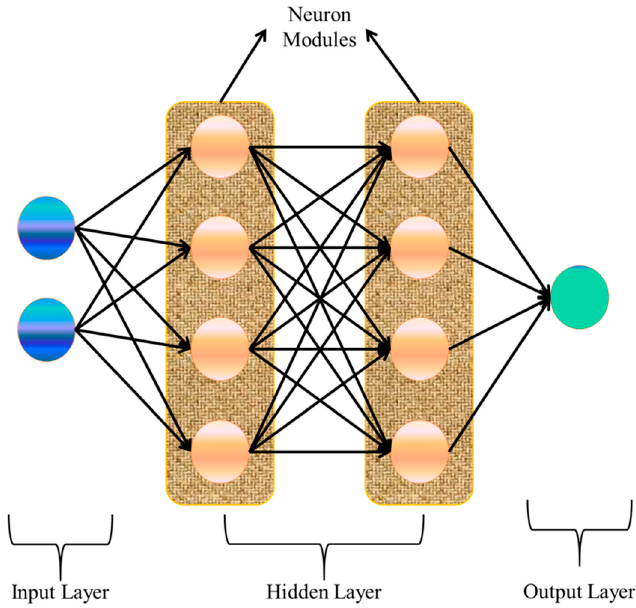
Figure 1. Deep neural network general framework.